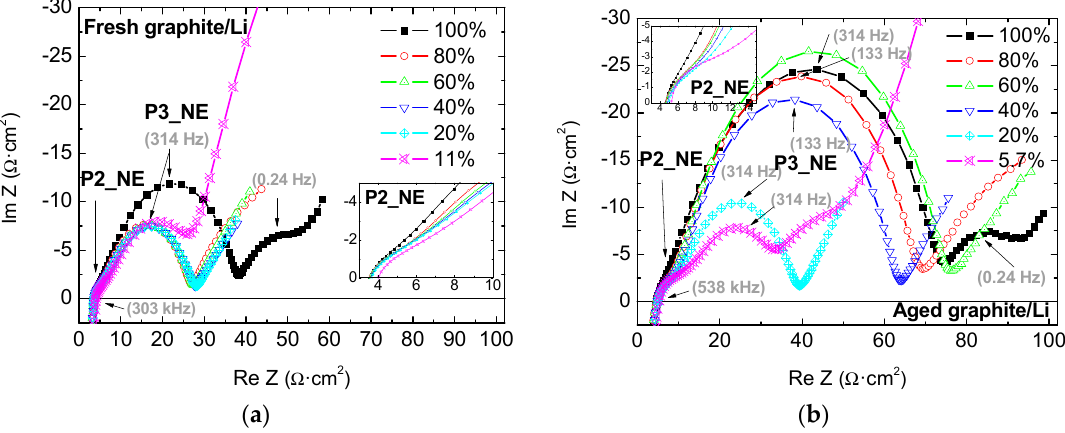
Figure 1. Impedance variation during lithium extraction from the negative electrode in the graphite/Li half-cell configuration in the ( a ) fresh state and ( b ) aged state. Percentages represent the negative electrode’s state-of-charge (SoC). Measurements are carried out at 25 °C. The P2_NE region is enlarged at the insets. Some selected frequencies are indicated by arrows.